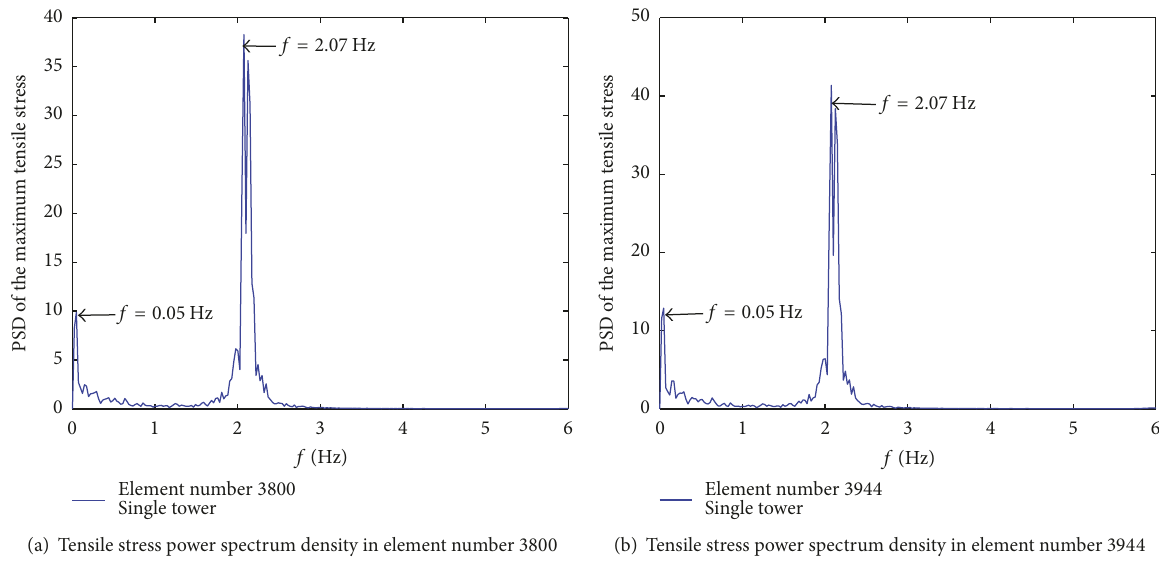
Figure 24: Stress PSD of the main members of the corresponding single transmission tower under the design wind speed ( 𝑈 10 = 25.3 m/s).